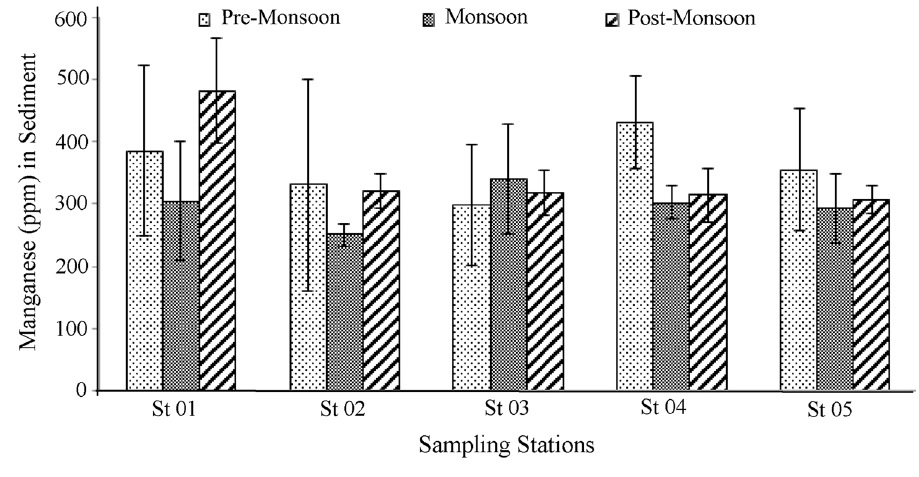
Fig. 5 Sediment copper con- centration (± SD) variation at different seasons in different sampling stations of Sundar- ban mangrove